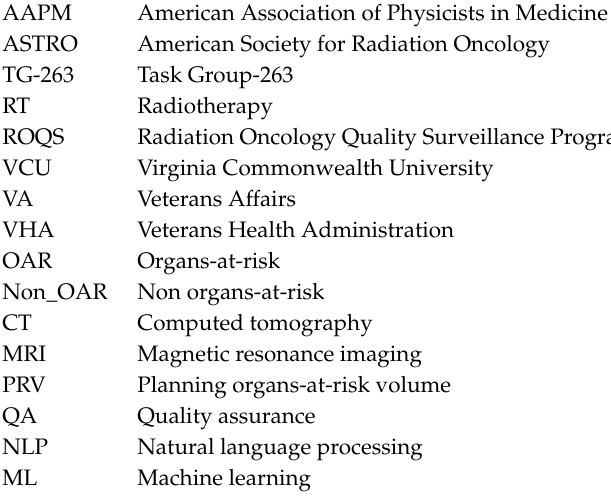
Figure S1: Radiotherapy Structure name distribution per center for Prostate cancer in the VA-ROQS dataset; Figure S2: Radiotherapy Structure names distribution per center for Lung cancer patients in the VA-ROQS dataset; Figure S3: Hyperaparameter Tuning of fasttext for VA-ROQS Prostate cancer dataset; Figure S4: Hyperaparameter Tuning of fasttext for VA-ROQS Lung cancer dataset; Figure S5: VA-ROQS Prostate 10 fold cross-validation results; Figure S6: VA-ROQS Lung 10 fold cross-validation results; Table S1: Initial Model Selection Results for VA-ROQS Prostate datasets; Table S2: Initial Model Selection Results for VA-ROQS Lung datasets; Table S3: VCU Test Set results of Prostate structures; Table S4: VA-ROQS dataset 70:30 validation results for Prostate structures; Table S5: VA-ROQS Prostate dataset 5 fold validation results; Table S6: VA-ROQS Prostate dataset 10 fold validation; Table S7: VA-ROQS Prostate Center validation results; Table S8: VCU Test Set results of Lung structures; Table S9: Table S11: VA-ROQS Lung dataset 5 fold validation results; Table S12: VA-ROQS Lung dataset 10 fold Validation results; Table S13: Error analysis of VA prostate structure names with 70:30 split validation; Table S14: Error analysis of VA-ROQS dataset Lung structure names with 70:30